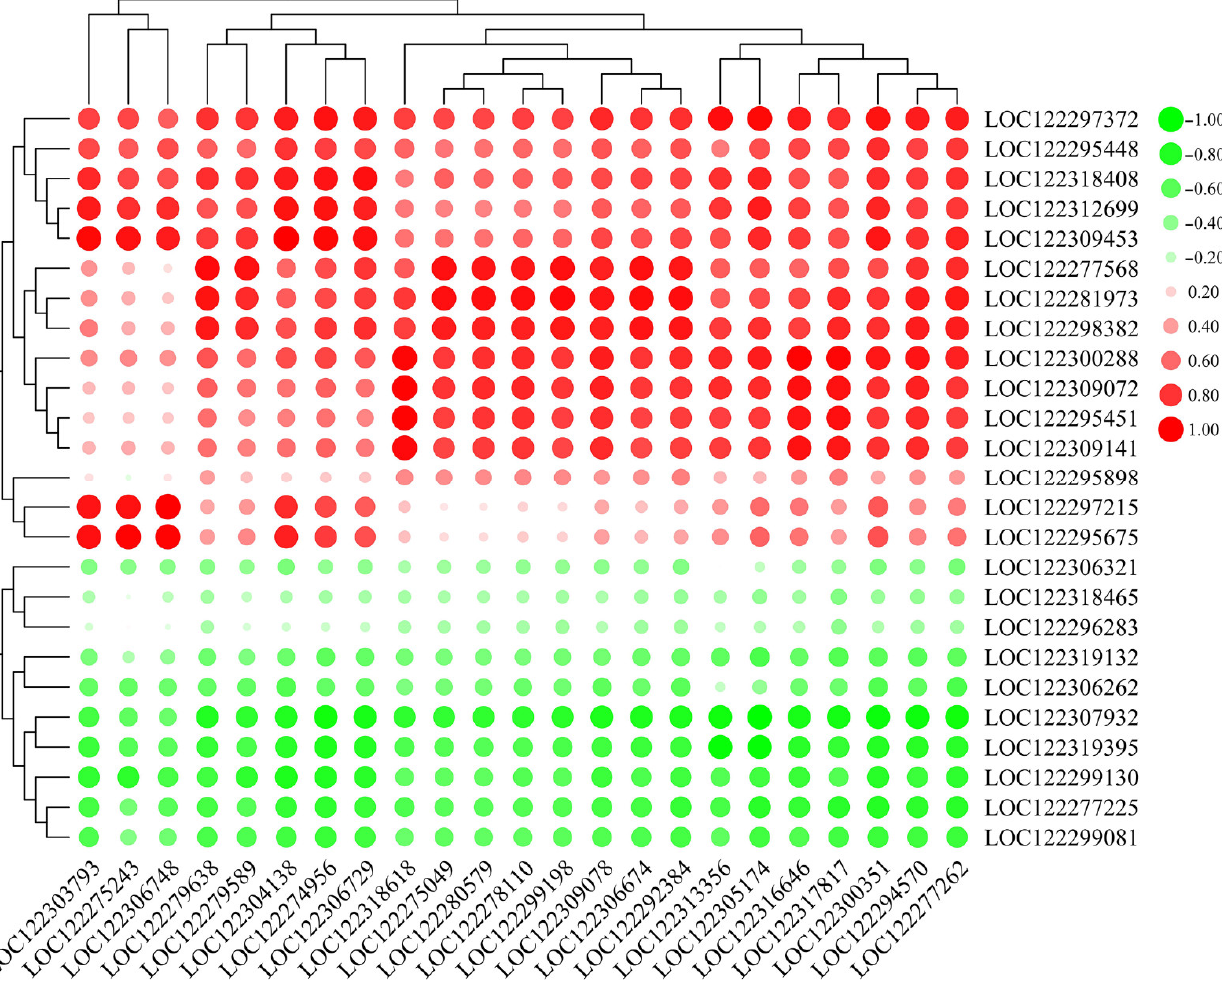
Figure 7. Correlation heat map of pathogen-related genes (PRGs) and WRKY TFs. Positive and negative correlations indicated by red and green circles, respectively; size of circle and intensity of color represent correlation strength. X -axis shows gene IDs of WRKY TFs, Y -axis shows gene IDs of PRGs.